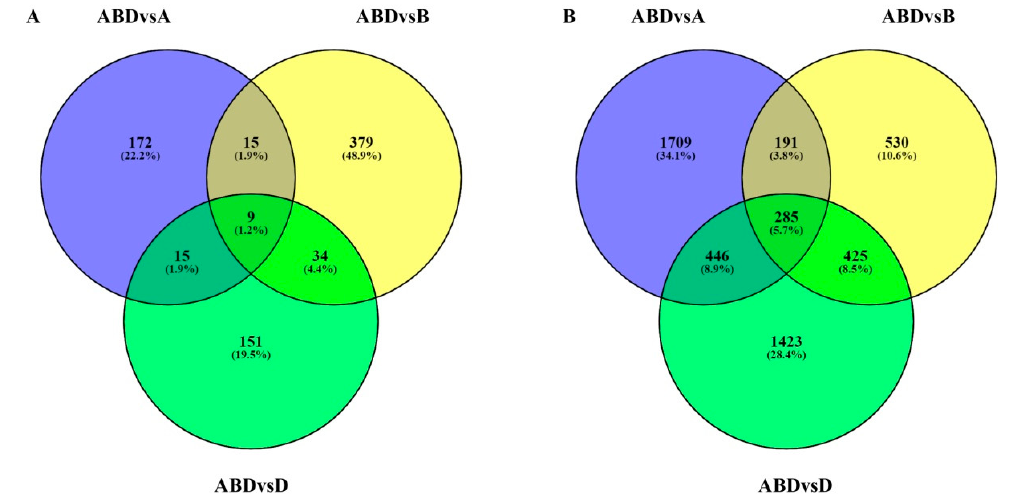
Figure 3. Di ff erentially expressed transcripts (log2fold > 10) in ABD vs. A, ABD vs. B and ABD Figure 3. Differentially expressed transcripts (log2fold>10) in ABD vs. A, ABD vs. B and ABD vs. D. vs. D. ( A ) Nine common di ff erentially up-regulated transcripts; ( B ) 285 common di ff erentially (a) Nine common differentially up-regulated transcripts ; (b) 285 common differentially down- down-regulated regulated transcripts